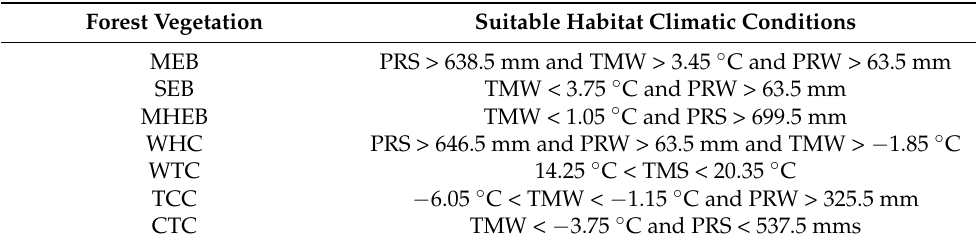
Table 6. Climatic conditions for suitable habitat of different forest vegetation types. Forest